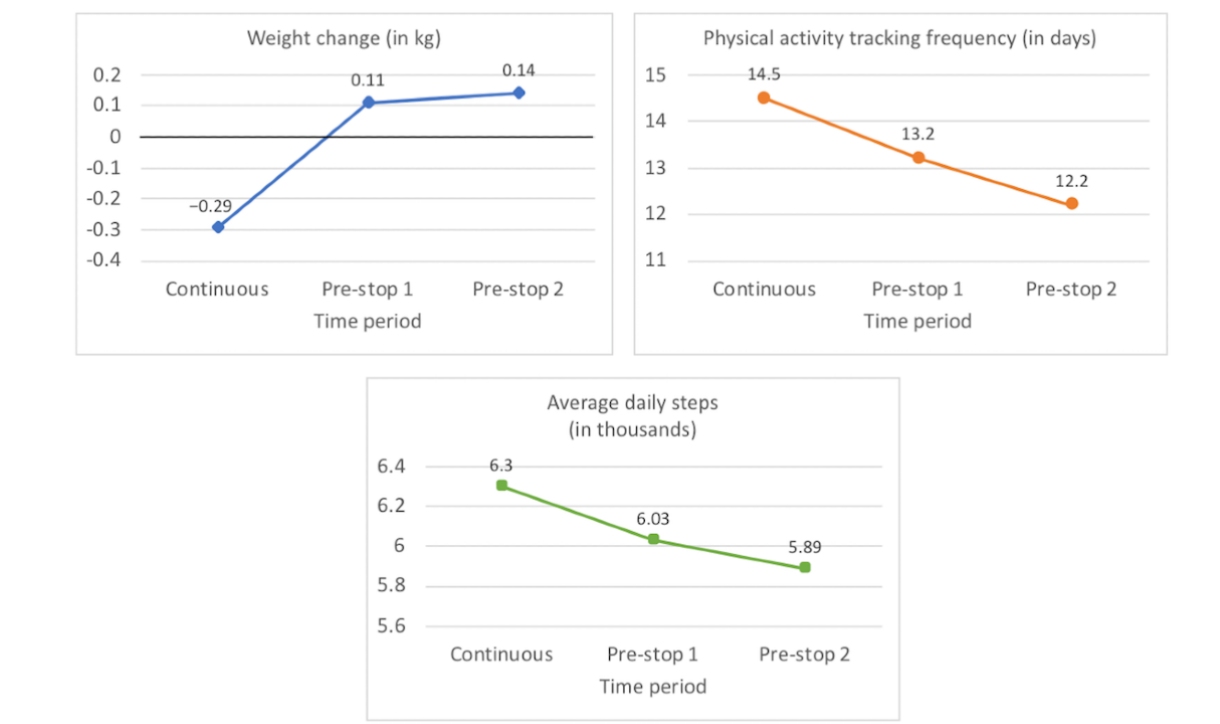
Figure 6. Results of the three linear mixed effects models of the post hoc